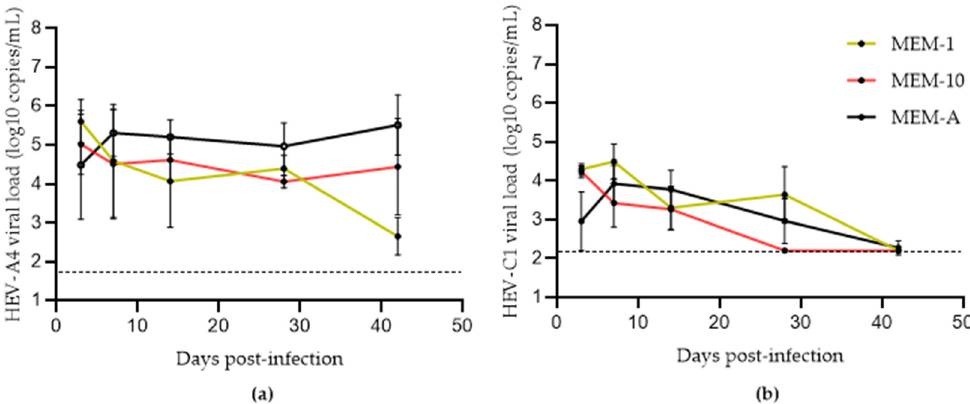
Figure 1. Growth of hepatitis E virus (HEV) in PLC/PRF/5 cells maintained in MEM-1, MEM-10, or MEM-A for ( a ) HEV-A genotype 4 (HEV-A4) and ( b ) HEV-C genotype 1 (HEV-C1) variants. Each data point represents the mean of three replicates. Error bars represent standard error of mean. Limit of detection of the RT-qPCR assay is represented by the dashed line (50 and 160 copies per mL for HEV-A4 and HEV-C1, respectively).